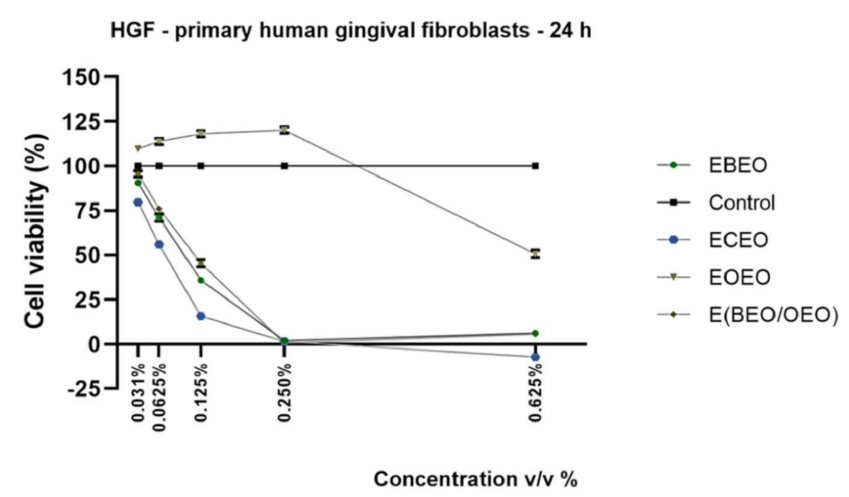
Figure 3. In vitro viability assessment EOs emulsions (EBEO, ECEO, and EOEO) and their mixture E(BEO/OEO) in HGFat 24 h post-stimulation by Alamar blue assay. The results are expressed as cell viability percentage (%) normalized to control (unstimulated cells). The data represent the mean values ± SD of three independent experiments.